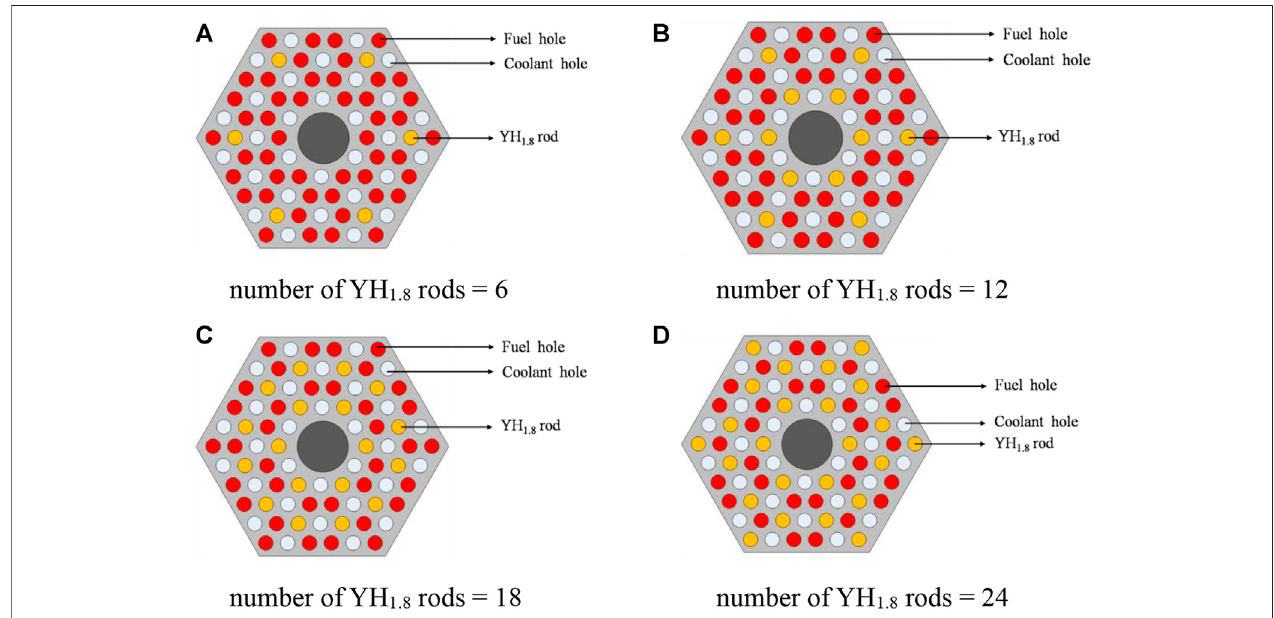
FIGURE 6 | Arrangements of YH 1.8 solid moderator rods in S-CO 2